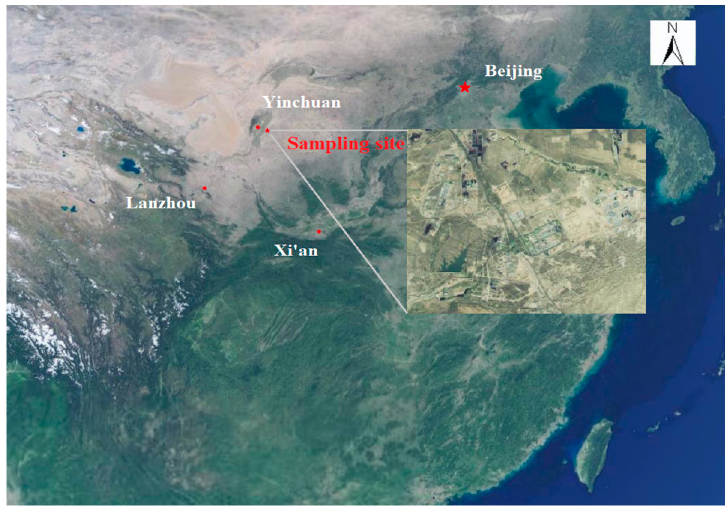
Figure 1. The location of sampling site.